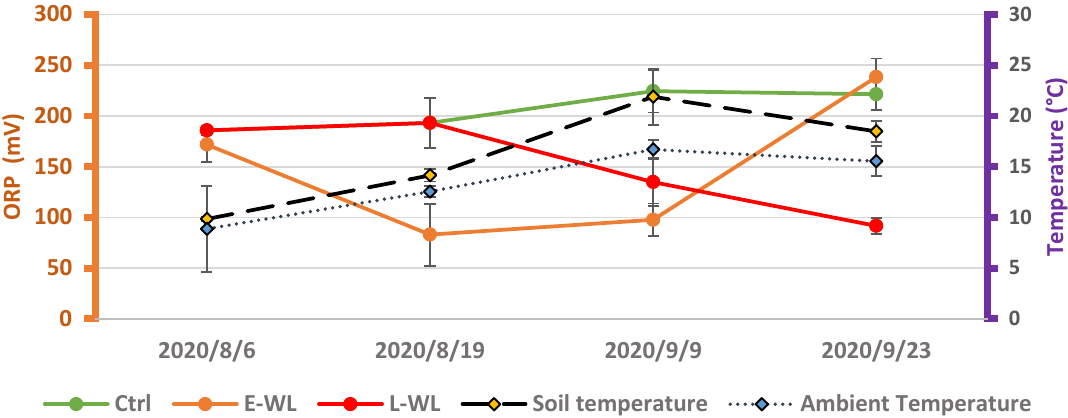
Figure 7. Soil oxidation–reduction potential (ORP), ambient and soil temperatures during non-waterlogged (control), early (E-WL) and late waterlogging (L-WL) treatments in Experiment 1; pH of 7.6 ± 0.03 remained consistent for the duration of experiment.